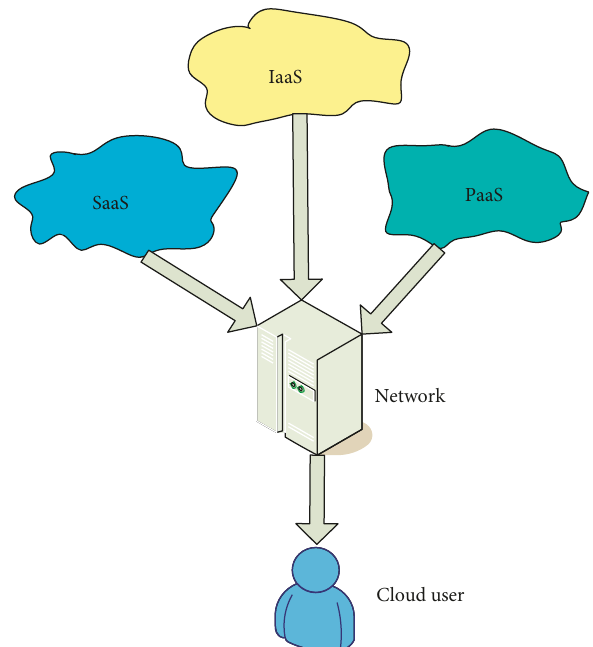
Figure 1: Schematic diagram of basic cloud computing service